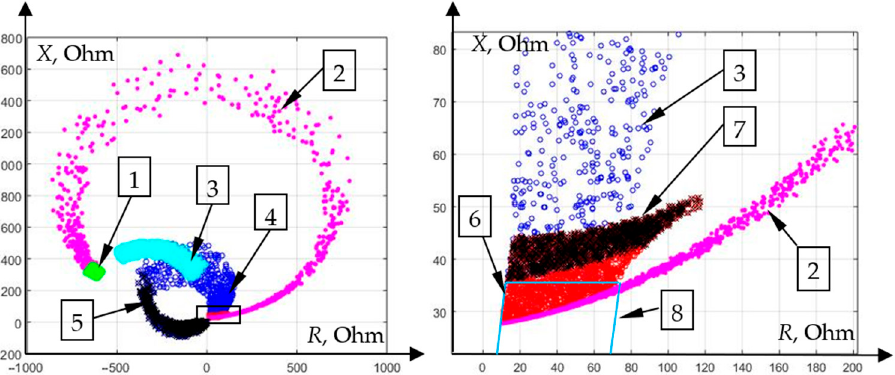
Figure 15. Areas of regimes on the complex plane. 1—normal modes; 2—short circuit on the primary winding T 1 ; 3—short circuit behind the line T 1 (at ω 4); 4—short circuit on ω 2 ; 5—short circuit on ω 2 (outside zone 1 of the protection stage ω 2 ); 6—short circuit on ω 3 ; 7—short circuit on ω 3 (outside zone 1 of protection stage ω 3 ); 8—triggering characteristic of distance protection.